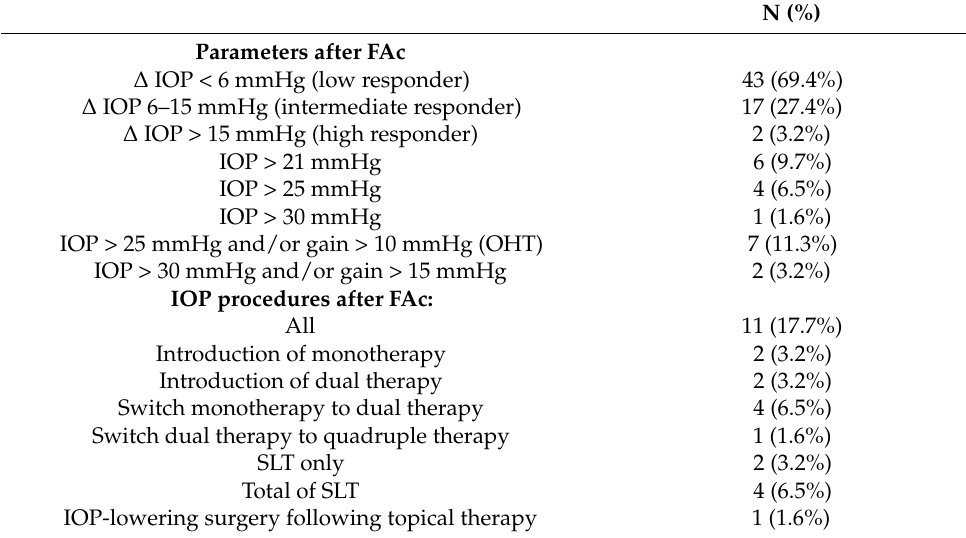
Table 4. Intraocular pressure